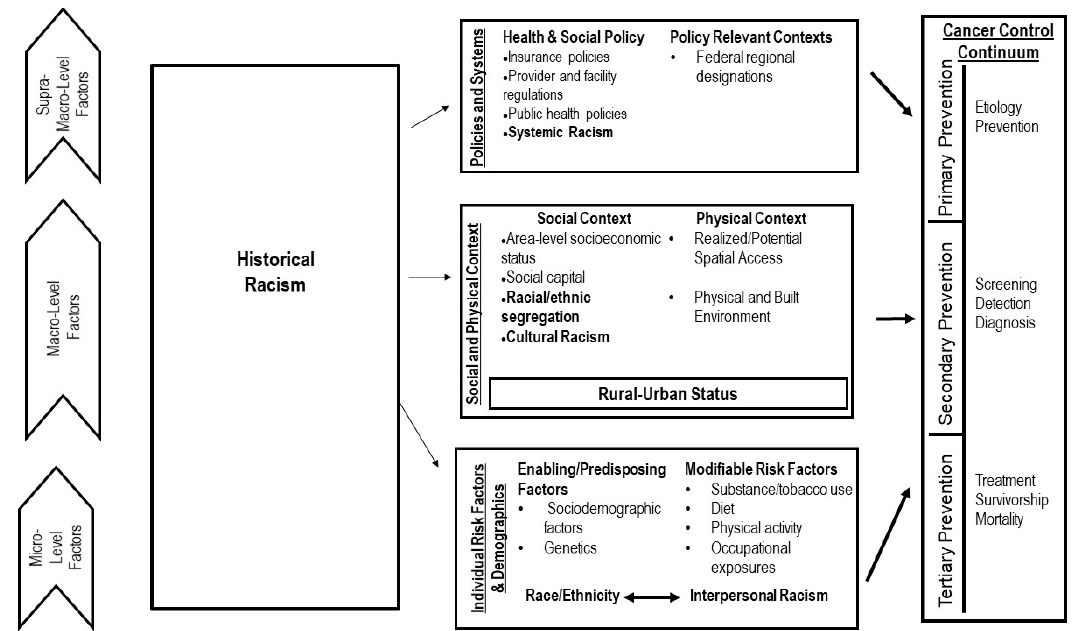
Figure 2. A conceptual framework of the multilevel influence of racism on rural cancer disparities across the continuum. The role of racism across levels in noted in bold.